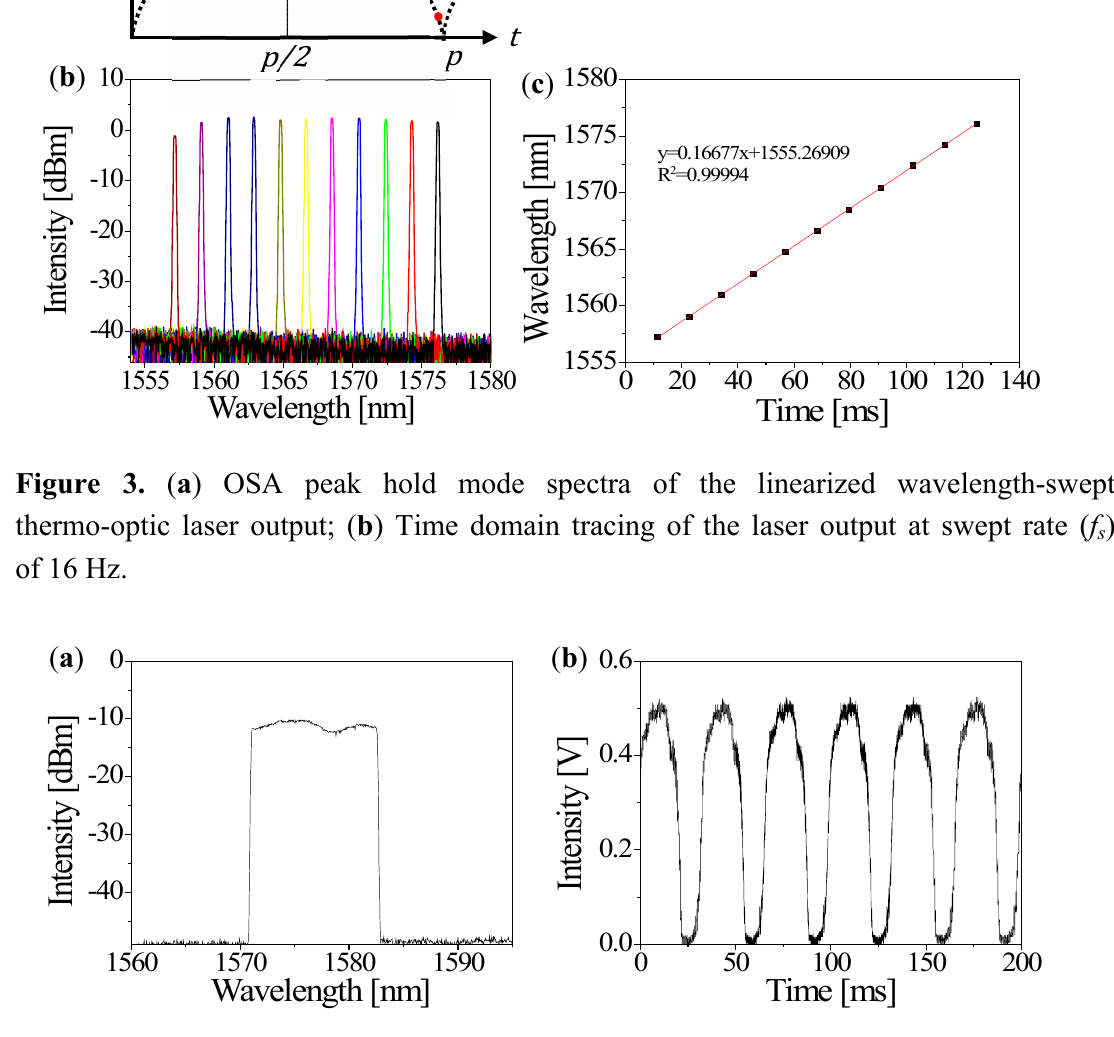
Figure 2. ( a ) The arbitrary drive signal of linearized wavelength-swept thermo-optic laser chip; ( b ) the static output spectrum of the laser; ( c ) wavelength versus time response of the laser chip.